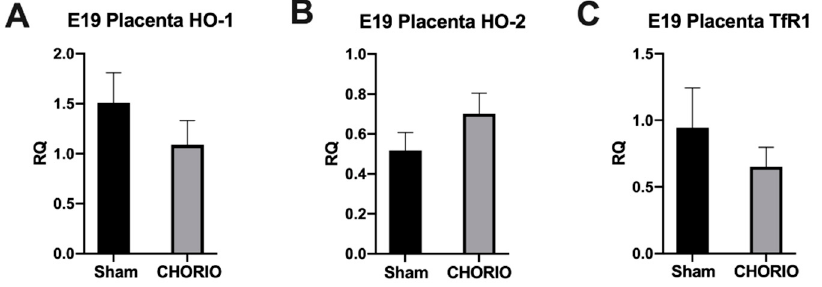
Figure 1. Placenta gene expressions for HO-1, HO-2, and TfR1 24 h after CHORIO, at E19, 24 h after CHORIO, at E19, no significant differences in placental gene expressions of HO-1 (( A ) n = 4 for CHORIO, n = 3 for sham), HO-2 (( B ) n = 4 for CHORIO, n = 3 for sham) or TfR1 (( C ) n = 3 for CHORIO, n = 3 for sham) was detected compared to sham. p > 0.05, data normally distributed, Welch’s t -test, 2-tailed, mean ± SEM.